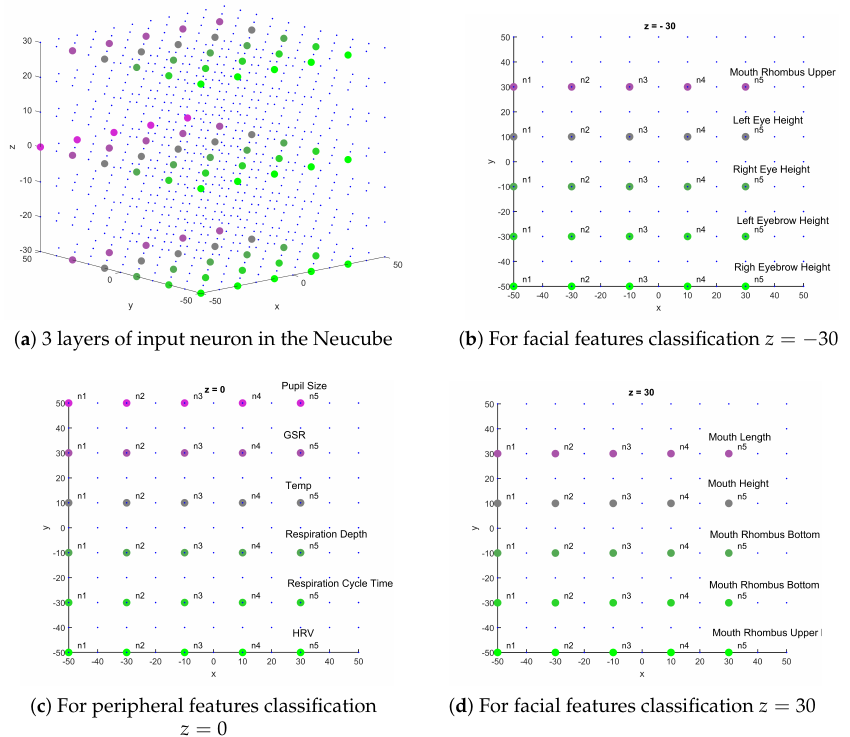
Figure 8. Input neurons location for facial and peripheral features classification. n1 means for the neuron coding the lowest values and n5 the highest ones for each feature. Note there are 3 layers of input neuron in the cube, located at z = − 30 (facial), z = 0 (peripheral), and z = 30 (facial). The SNNr was made with leaky integrate and fire model (LIFM) spiking neurons with recurrent connections. In this neuron model, the post-synaptic potential (PSP) increases or decreases with every input spike from pre-synaptic neurons. The effect of each spike is modulated by the corresponding synaptic connection weight. If PSP reaches a specific threshold (0.5 in this work), then the neuron emits an output spike toward its connected neighbours and the PSP resets to a reference value. The PSP can leak between spikes with a predefined time constant τ , if we are using an exponential model or a constant leak time. The latter is used in this work and is set to 0.002. After a neuron spikes, the absolute refractory time (equal to 1 in this work) is simulated by disabling it to increase the PSP until a certain unit time has passed. Figure 9 shows an example of LIFM neuron simulation with a refractory time that is equal to three seconds, potential leak rate equal to 0.02, a threshold of firing that is equal to 0.5 and synapses weights of 0.1, 0.1, and 0.35. It can be noted in Figure 9 that the accumulation of spikes in time leads to an increase of PSP until a spike is generated and the effect of disregarding input spikes immediately after a spike is